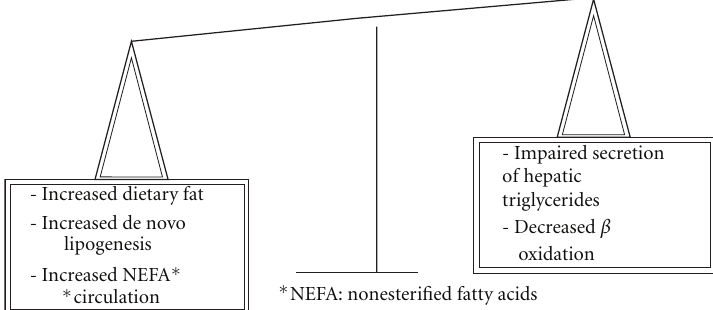
Figure 1: Pathways contributing to steatosis. An imbalance between fatty acid uptake, de novo synthesis and elimination of free fatty acids through oxidation and secretion into the blood with very low density lipoprotein triglycerides (VLDL), contributes to the development of